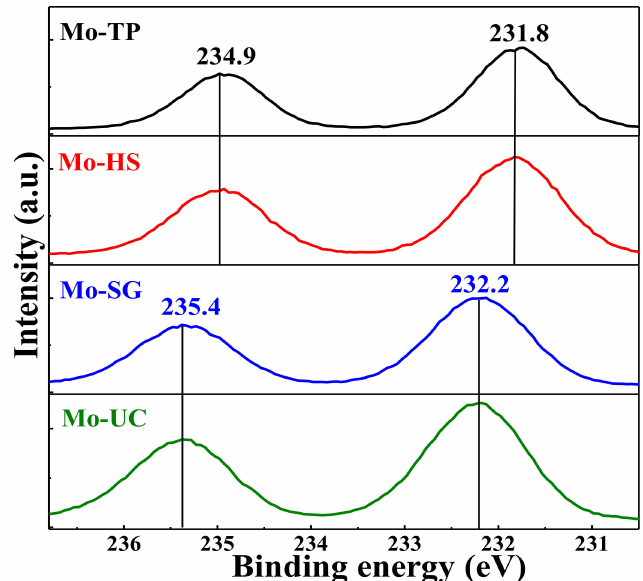
Figure 6. Mo 3d 3/2 and Mo 3d 5/2 peaks of the Mo/ZnAl-LDH